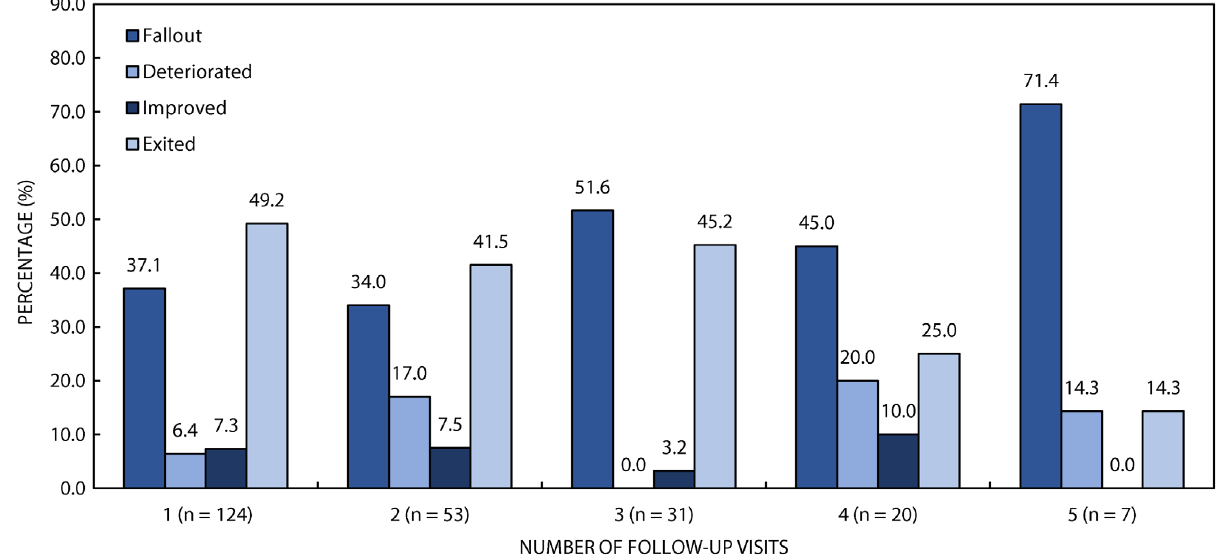
Figure 2: Percentage of children who deteriorated, improved and exited, as well as fallout patients per number of follow-up